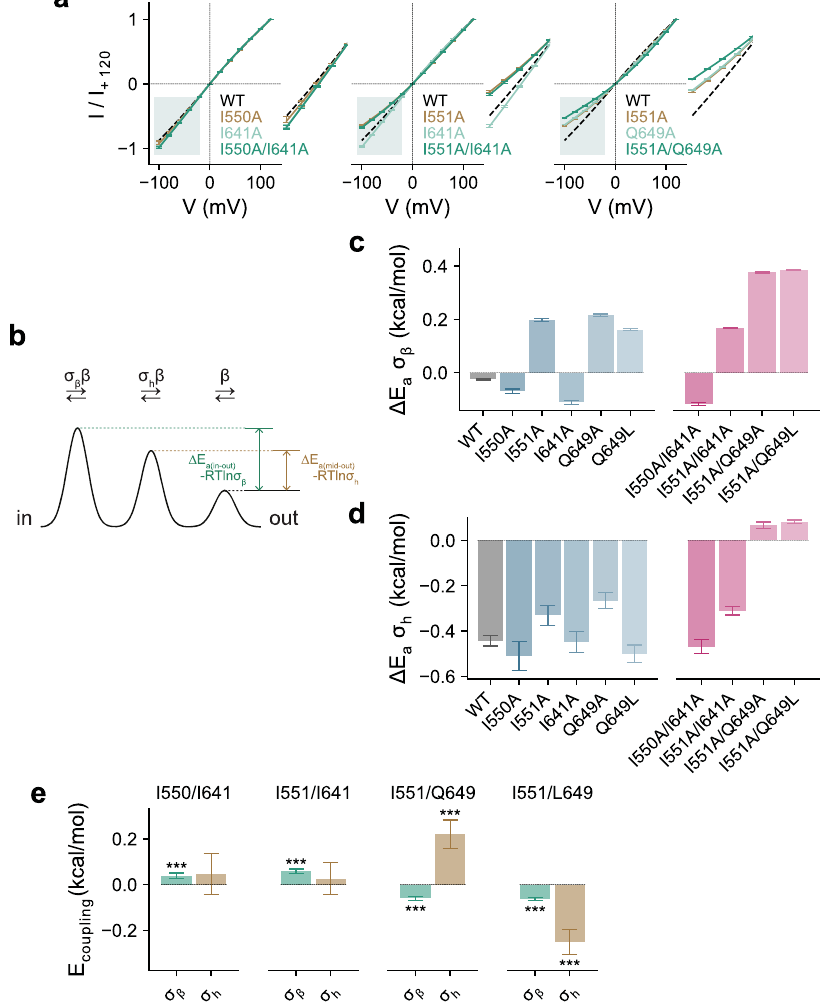
Fig. 5 Functional coupling in the open state. a Instantaneous I-V relations for the indicated mutants recorded at saturating Ca 2 + concentrations. Solid lines are fi ts to a phenomenological ion permeation model described in Eq. 1. Dashed line indicates the relation of WT. Data are averages of the indicated number of patches (WT, n = 6; I550A, n = 6; I551A, n = 8; I641A, n = 7; Q649A, n = 6; I550A/I641A, n = 10; I551A/I641A, n = 10; I551A/Q649A, n = 16), errors are SEM. b Minimal ion permeation model to account for the I-V relations. c , d Conduction parameters c , Δ E a ( σ β ) and d , Δ E a ( σ h ) corresponding to the barrier heights for ion conduction at the inner pore entrance and the narrow pore relative to that of the outer barrier of the indicated mutants. Bars indicate quantities calculated using Eq. 2 from the best- fi t values of the averaged data shown in a . Errors are 95% con fi dence intervals. e Coupling energy ( E coupling ) for residue pairs. Bars indicate quantities calculated using Eqs. 31 – 32, 35 from the values shown in c and d . Errors correspond to standard errors. Asterisks indicate signi fi cant deviation from zero in a two-sided one-sample t -test (I550/I641: *** p = 0.002; I551/I641: *** p = 1e − 8; I551/Q649: *** p = 4e − 11 and *** p = 4e − 4; I551/L649: *** p = 2e − 16 and *** p = 6e −